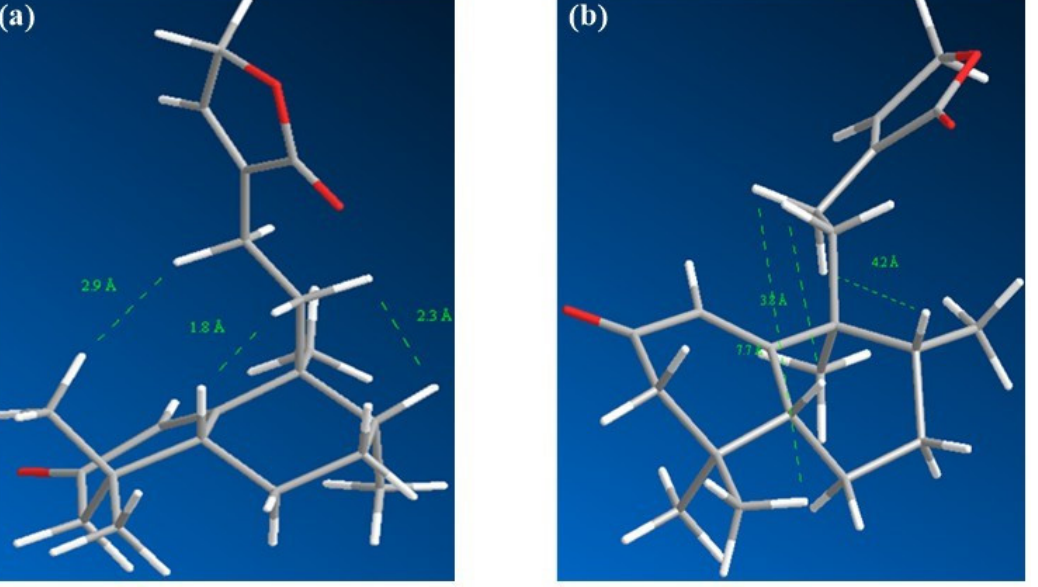
Figure 4. Three-dimensional representation of compound 1 . ( a ) Axial orientation of the (5H)-furan-2- one-bearing side chain on the ring. ( b ) Equatorial orientation of the (5H)-furan-2-one-bearing side chain on the